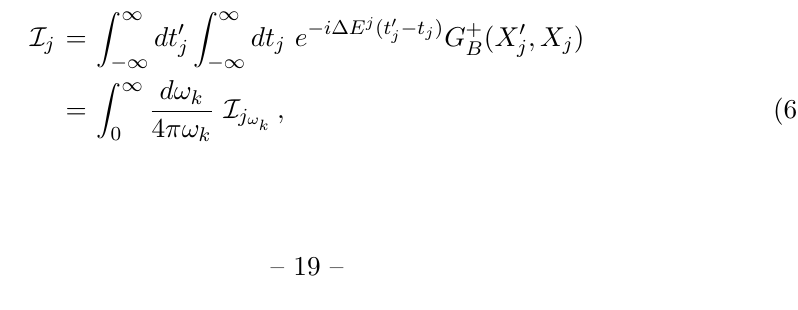
is plotted for two outgoing null detectors in a (1+1) dimensional Figure 6 . The quantity |I ε | /r 2 H ωk Schwarzschild black hole spacetime with respect to the dimensionless transition energy ∆ E = r of the detectors, where ∆ E = ∆ E A = ∆ E B . The dimensionless field mode frequency is fixed at ω k = 1 and the other fixed parameter are d/r H = 0 and d/r H = 1